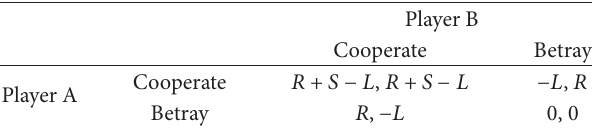
Table 1: Basic payoff